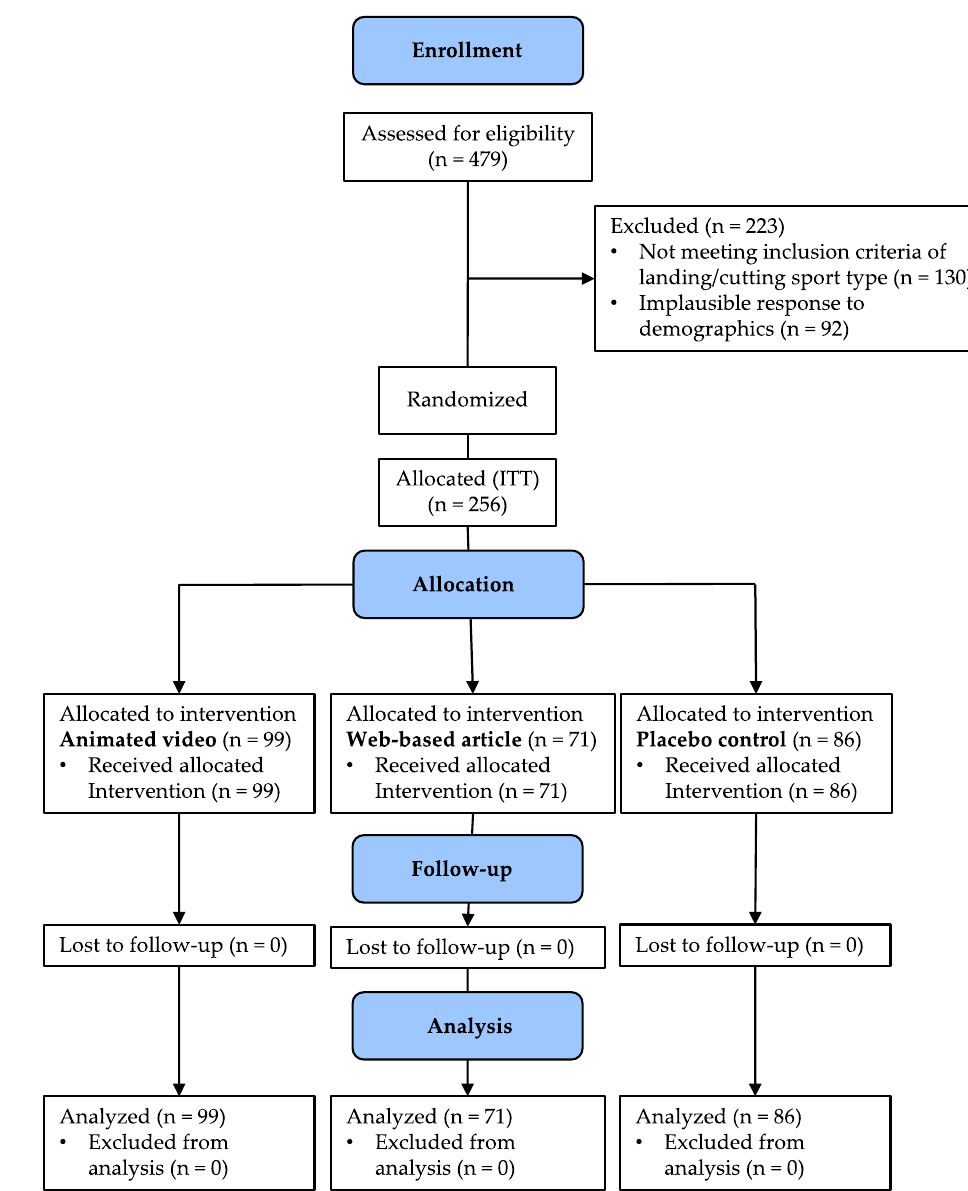
Figure 1. Participant flow chart.